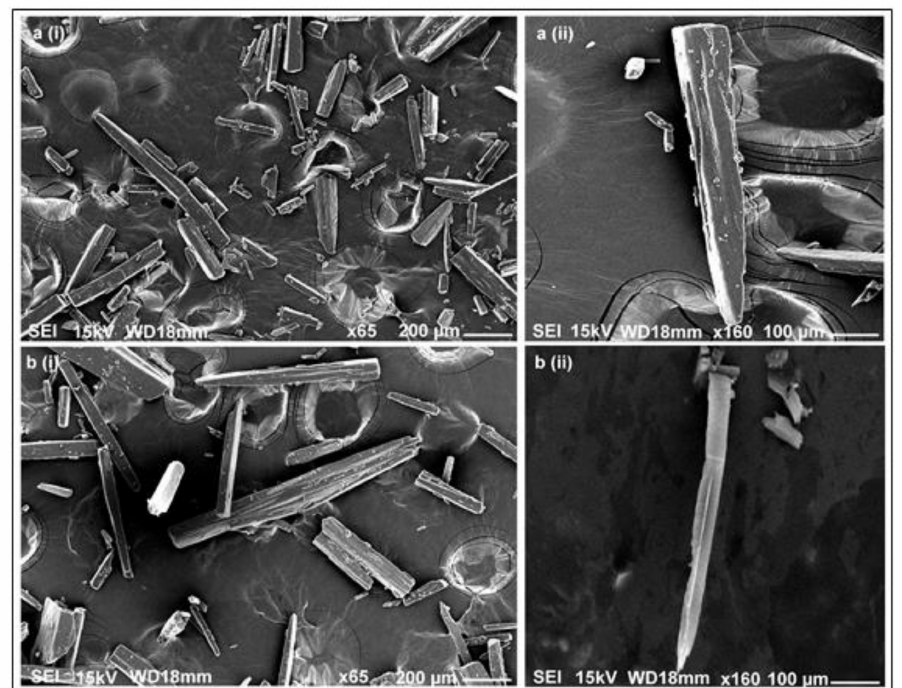
Figure 4. Scanning electron microscopic images of pure L-alanine crystals taken at ( a ) (i) × 65 and ( a ) (ii) × 160 resolution and of L-alanine produced by the recombinant strain taken at ( b ) (i) × 65 and ( b ) (ii) × 160 resolution, respectively, both showing needle-like crystal